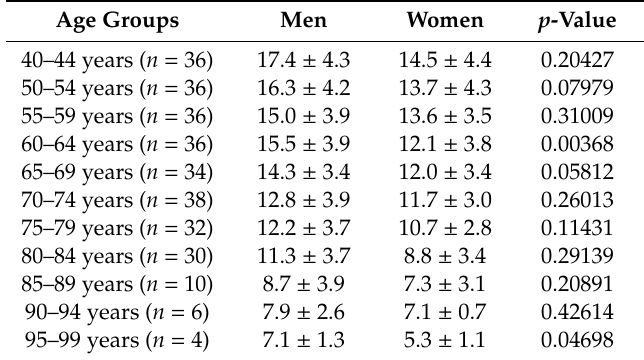
Table 2. Average running speed (km·h − 1 ) of the American masters road running records by age-group. Data expressed as mean and standard deviation (±).